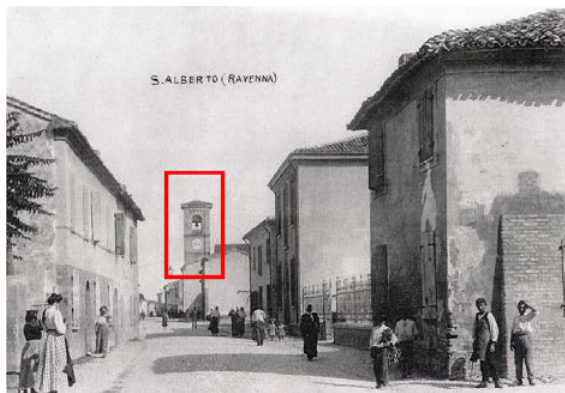
Figure 6. Identification and texturing of the 3D model surfaces.